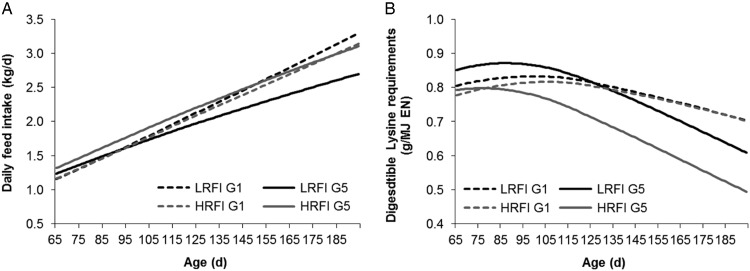
Curves for daily feed intake and digestible lysine requirements during the
growing–finishing period of low residual feed intake (LRFI) and high RFI (HRFI)
lines in generations G1 and G5 of selection as predicted using the
INRAPorc® model (n=1370). First, recorded BW were used
to fit a Gompertz model to the repeated BW records. Next, the daily feed intake
(DFI) records were modelled for each individual with a non-linear exponential model
DFI=a×BWb (Gilbert et al., 2009). Finally the daily digestible lysine requirements were calculated
individually with InraPorc® on the basis of modelled protein deposition
and observed growth and DFI curves as described in Saintilan et al.
(2015).